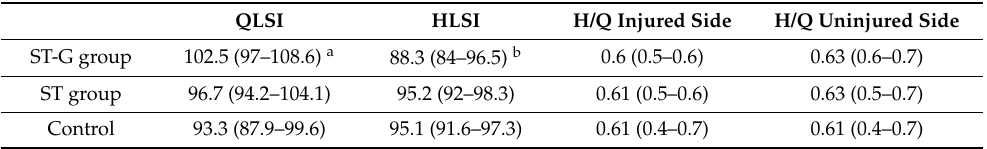
Table 3. LSI and H/Q ratio strength 5 years after reconstruction and in the control group. Results are expressed as medians (25–75% interquartile range). QLSI—Quadriceps Limb Symmetry Index; HLSI—Hamstring Limb Symmetry Index; H/Q—Hamstring to Quadriceps Ratio; ST—semitendinosus; ST-G—semitendinosus and gracilis. The values of the injured side were compared with those of the nondominant side of controls. The values of the uninjured side were compared with the values of the dominant side of controls. a p =0.01 when comparing the ST-G and control groups. b p = 0.033 when comparing the ST-G with ST and control